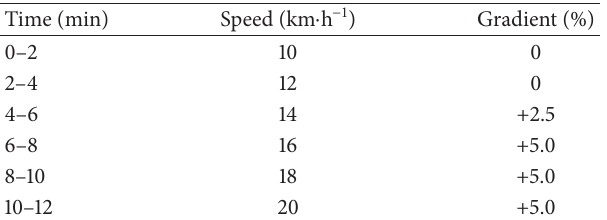
Table 1: Incremental treadmill test